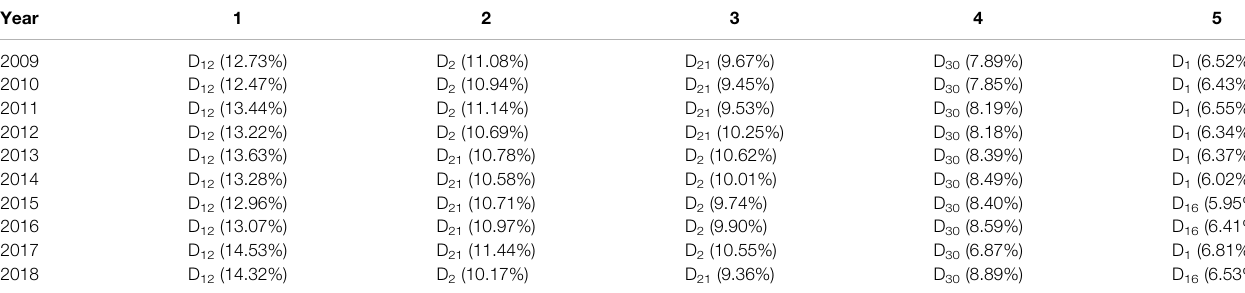
The table only listed the top fi ve factors of obstacle degree.